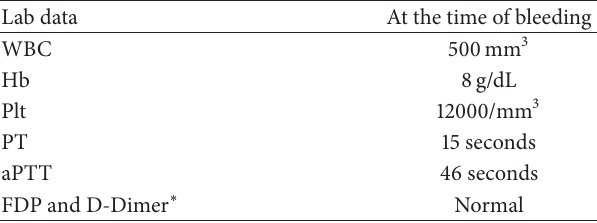
∗ Fibrinogen level was not